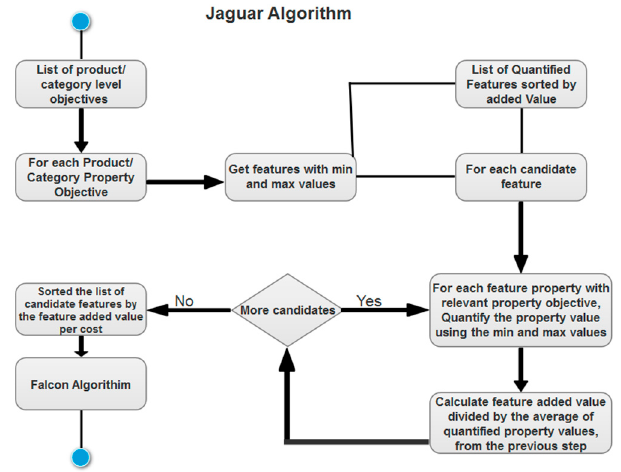
Figure 3. The Jaguar sorting.